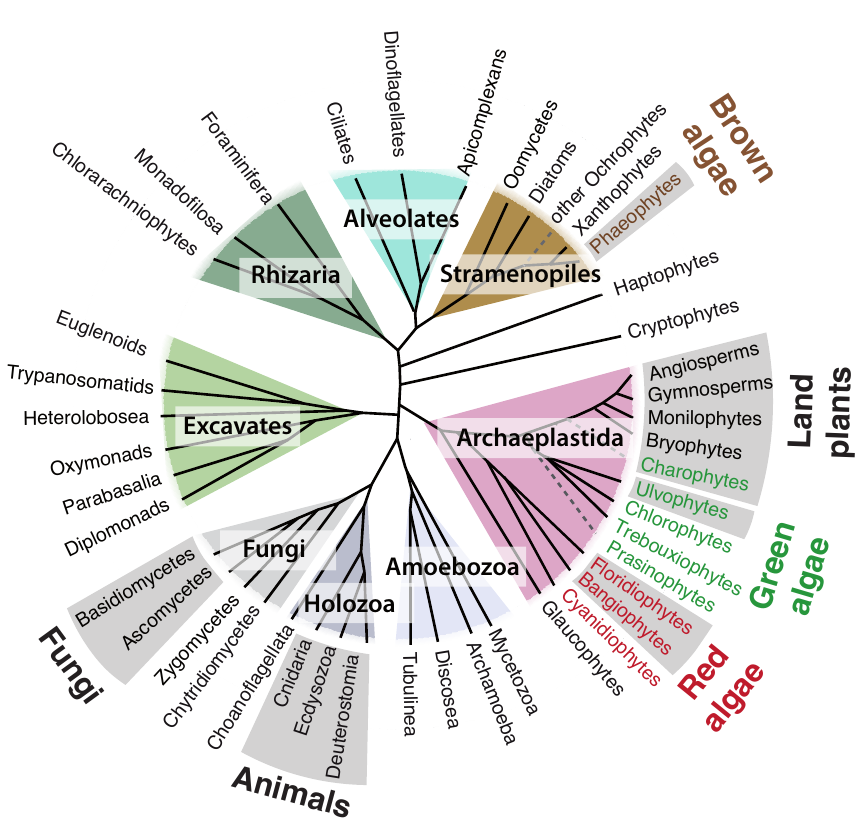
Figure 1. Schematic tree of the eukaryotes showing the phylogenetic positions of the brown, green, and red macroalgal lineages. Gray sectors mark lineages that have given rise to complex multicellular species. Adapted from Coelho and Cock, 2020